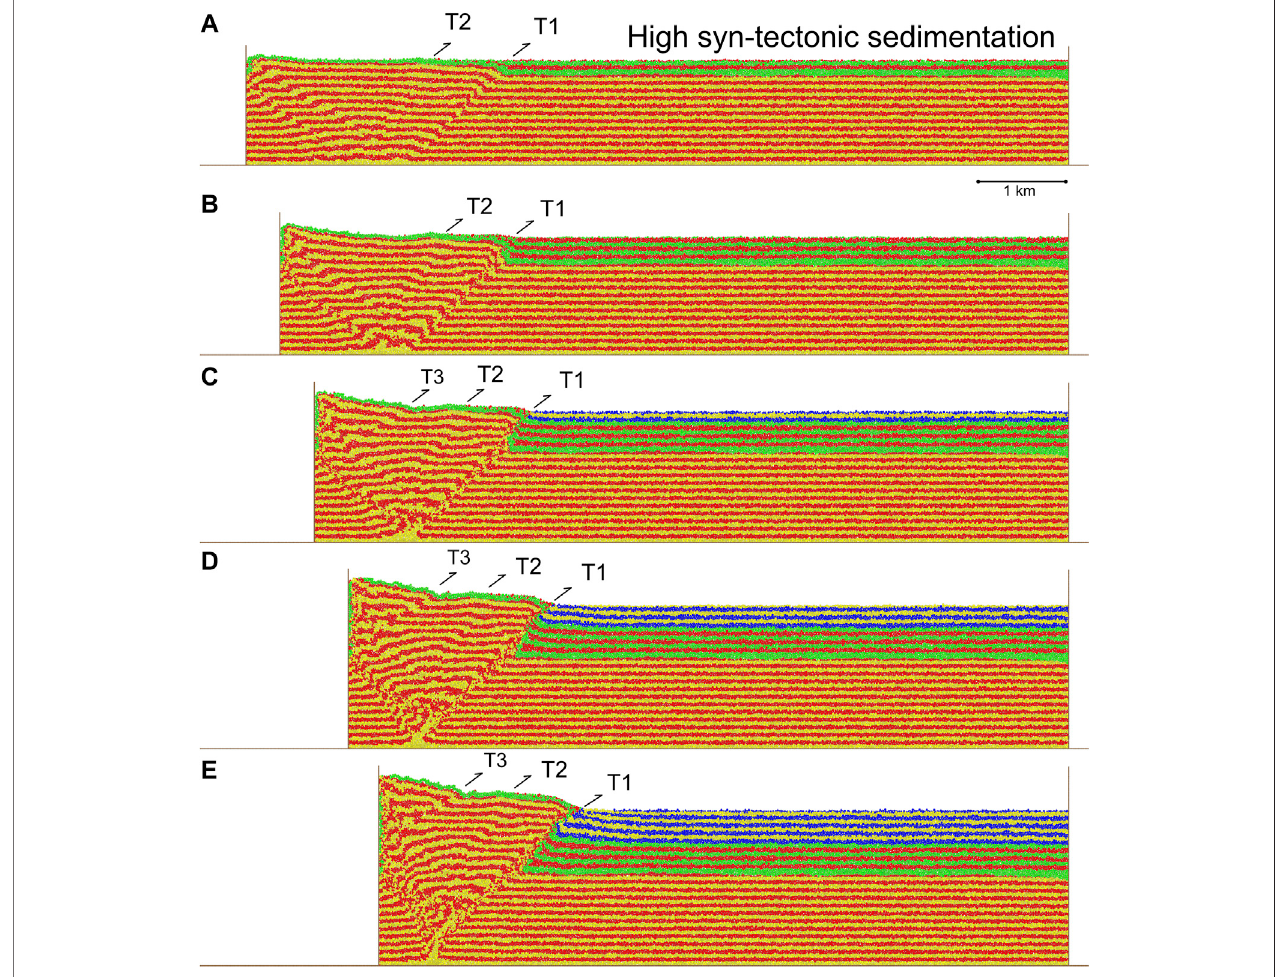
FIGURE 5 | Experiment 4, progressive evolution of a contractional model with “ high ” syn-tectonic sedimentation. Results are shown after 500 (4%), 1,000 (8%), 1,500 (12%), 2000 (16%), and 2,500 (20%) m contraction/displacement on the left-hand end-wall. Two distinct growth packages are highlighted/coloured in order to show the stratal architectures developed inearly (green-red package) and mid/late (blue-yellow package) fault array growth, the transition occurringat c. 1,250(10%) m of lateral contraction, see text for discussion.